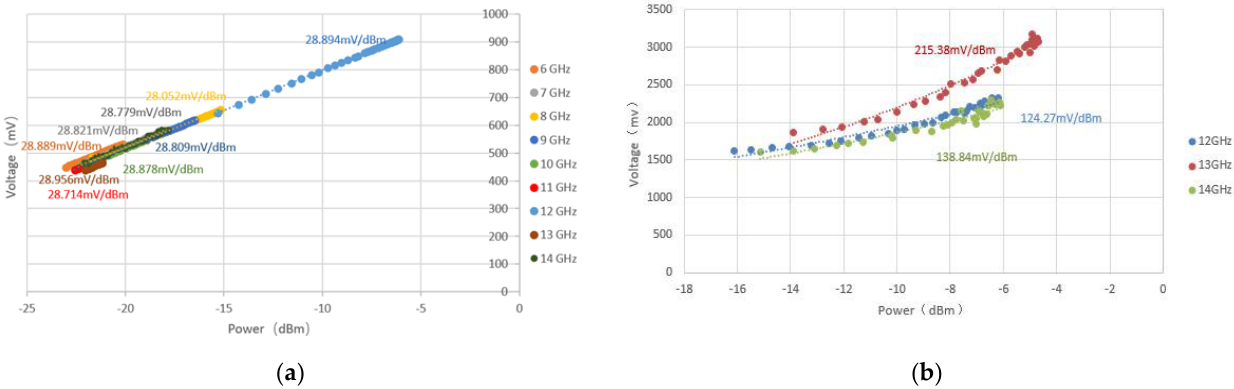
Figure 19. ( a ) Measured results of the detection sensitivity of full-power microwave temperature radiometer; ( b ) measured results of the detection sensitivity of the novel interferometric microwave temperature radiometer.